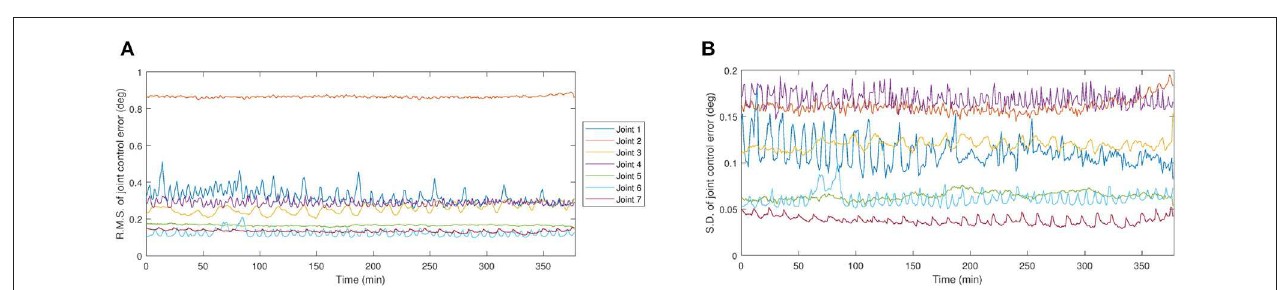
FIGURE 8 | Evaluation of the angular position control performance of the robot at each joint. (A) The root mean square (R.M.S.) of the control error at each joints. (B) The standard deviation (S.D.) of the control error at each joints.